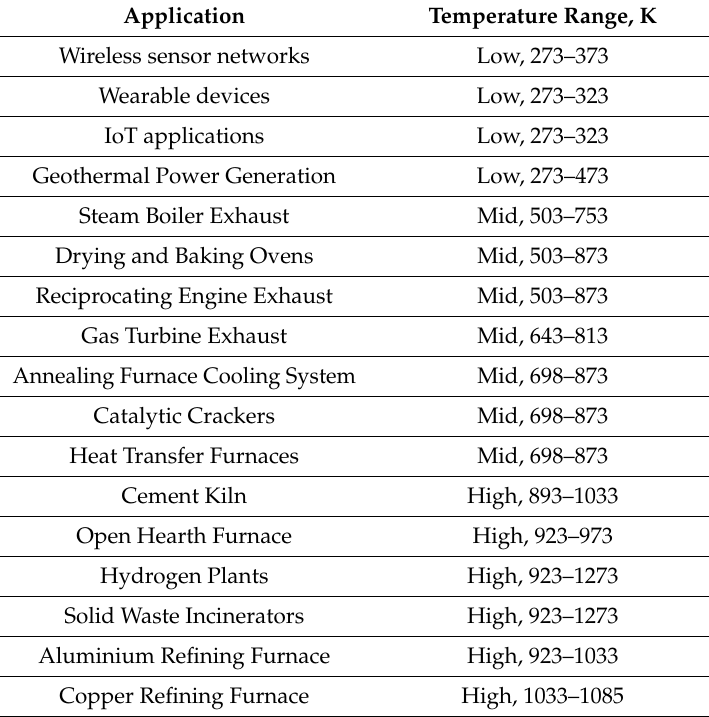
Table 1. Possible thermoelectric generator (TEG) applications, mild and high temperature range applications adopted from Ovik et al. 2016 [23].